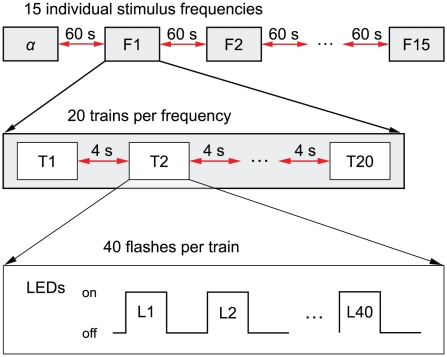
Experimental design of the flicker stimulation study.The LEDs were powered for half of each period. The raise and decay time for the LEDs was measured to be 100 µs.